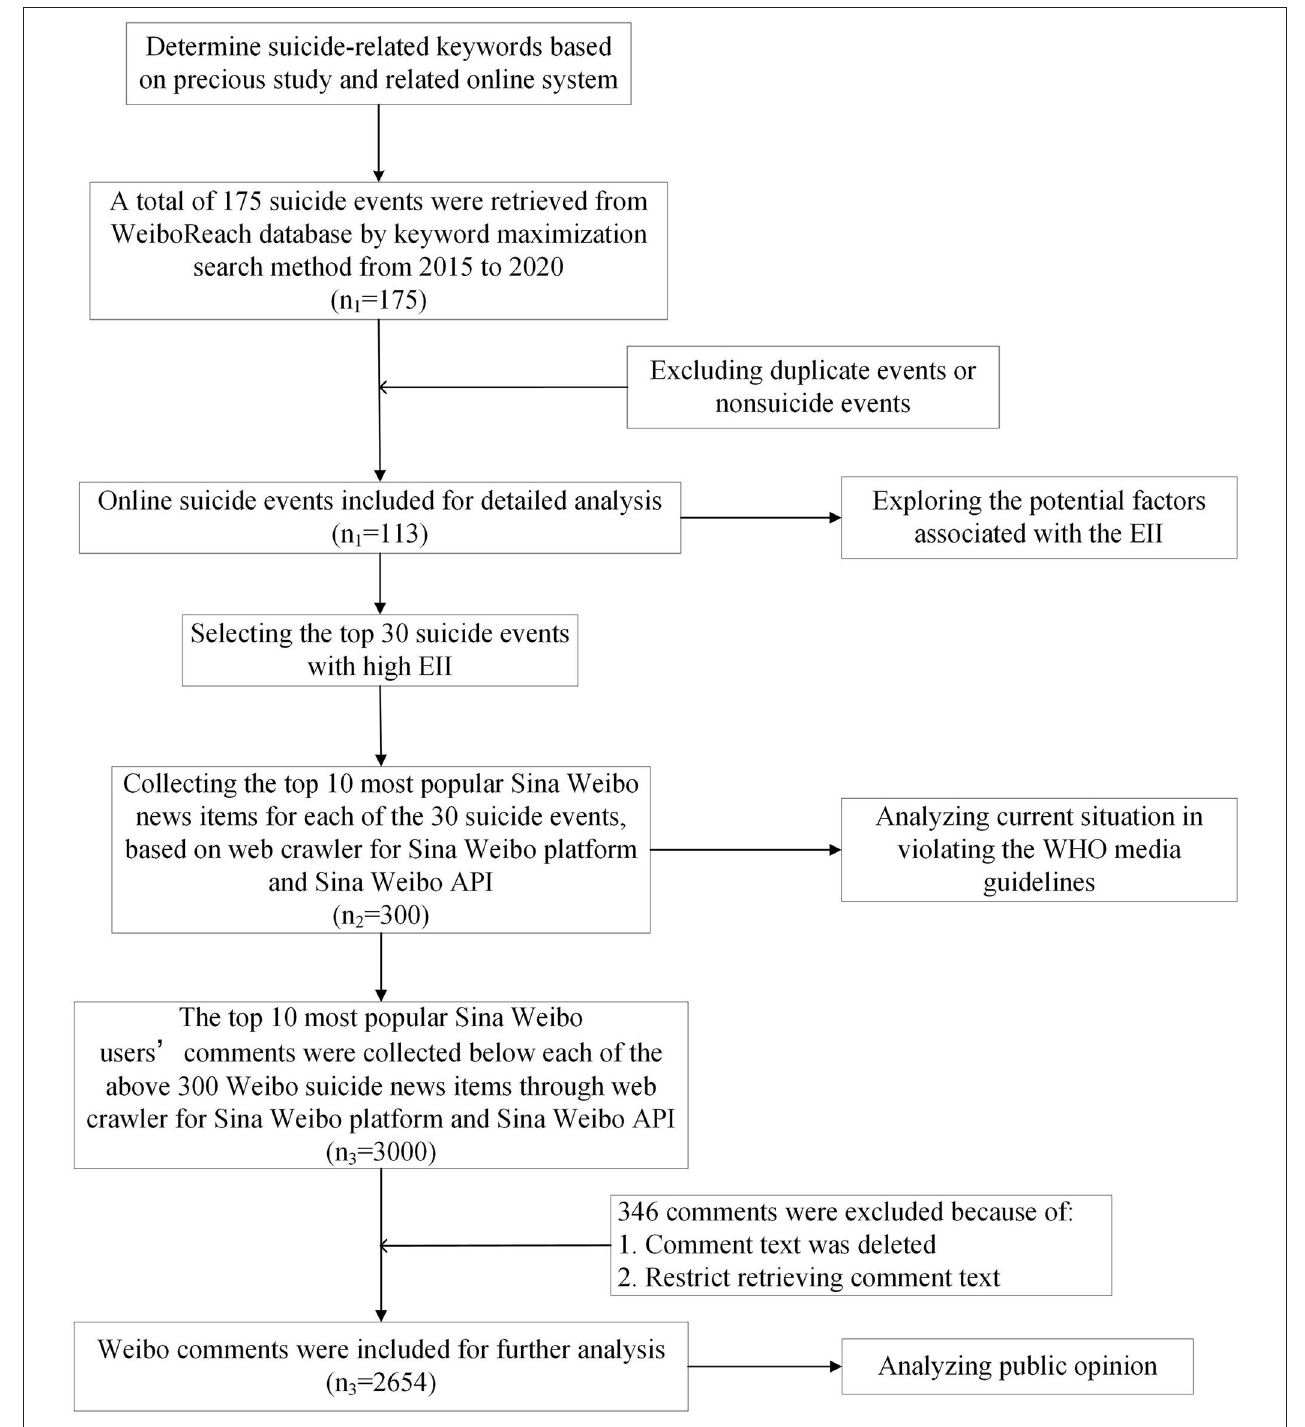
FIGURE 1 | Flow chart of the study. EII, Event Influence Index.